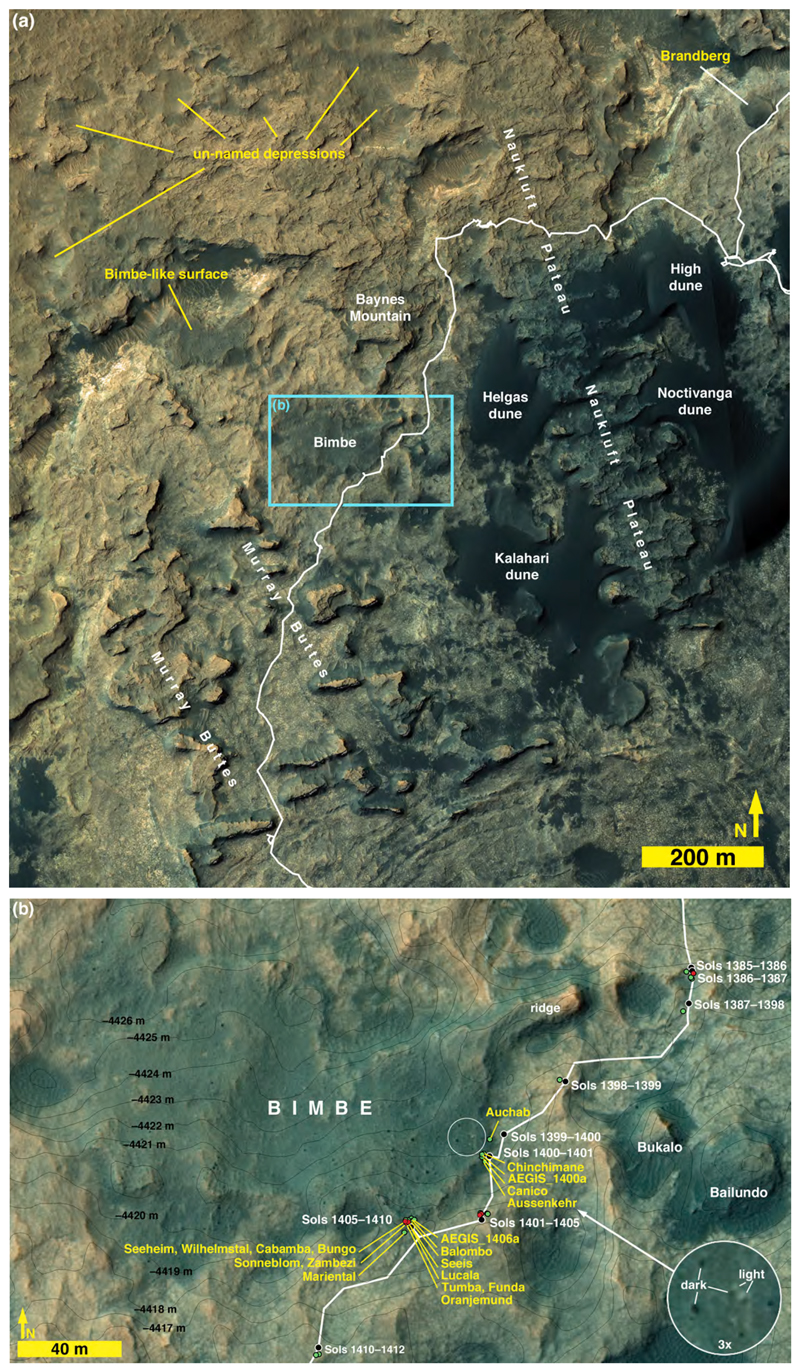
(a) Local context of Bimbe on the lower slopes of Mt. Sharp, between the Murray buttes to the south, Naukluft Plateau and some of the Bagnold dunes to the east, and Baynes Mountain to the north. The white trace is the Curiosity rover traverse; the drive direction was from northeast (upper right) toward the south (bottom left of center). Blue box indicates the location of (b): Bimbe with ChemCam, APXS, and MAHLI targets indicated in yellow. Green dots indicate ChemCam targets, red dots indicate APXS targets, and black dots indicate rover parking spots. The inset, a 3× expanded view of the area inside the white circle next to target Auchab, shows an example of light- and dark-toned boulders as observed from the orbiting HiRISE camera. The white trace is the Curiosity rover traverse; the drive direction was from the northeast (upper right) toward the south (bottom center). The elevation contours are derived from HiRISE stereo-pair products calibrated to Mars Global Surveyor (MGS) Mars Orbiter Laser Altimeter (MOLA), topography by Parker and Calef (2016). (For interpretation of the references to color in this figure, the reader is referred to the web version of this article.)